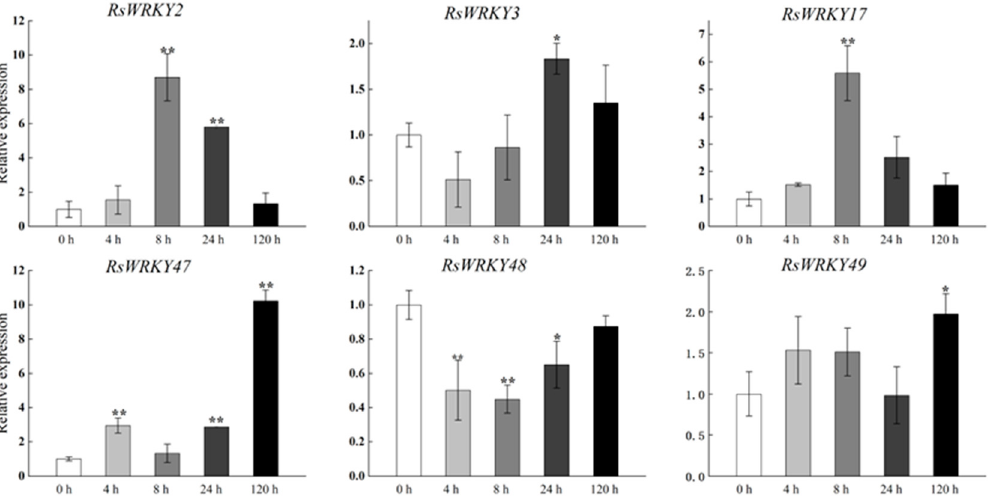
Figure 8. Expression profiles of RsWRKY genes under drought treatment. Gene expression at 0 h was normalized as “1.” Data are meant ± standard deviation (SD), calculated from three biological replicates, and vertical lines represent the standard deviation. * and ** mean significant difference at p < 0.05 and p < 0.01,